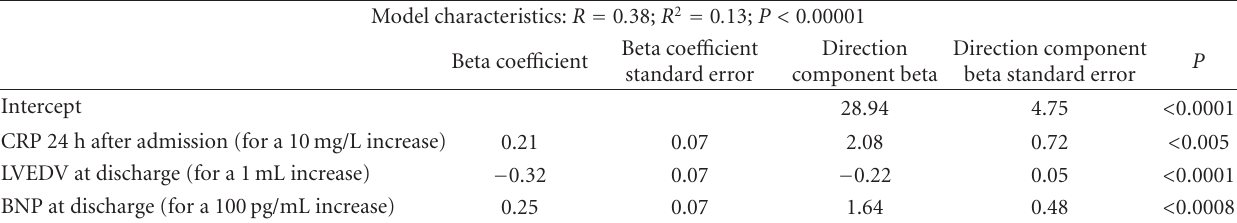
Table 5: Impact of demographic, clinical, angiographic, and biochemical variables from Tables 1, 2, and 3 on an increase in end-diastolic left ventricular volume between hospital discharge and 6-month